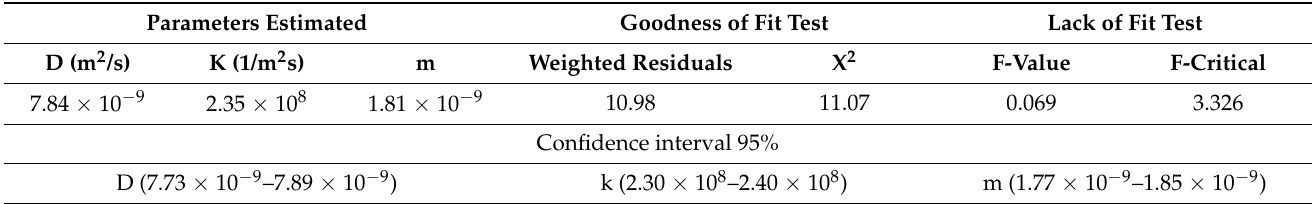
Table 2. Parameters estimated from drug-release